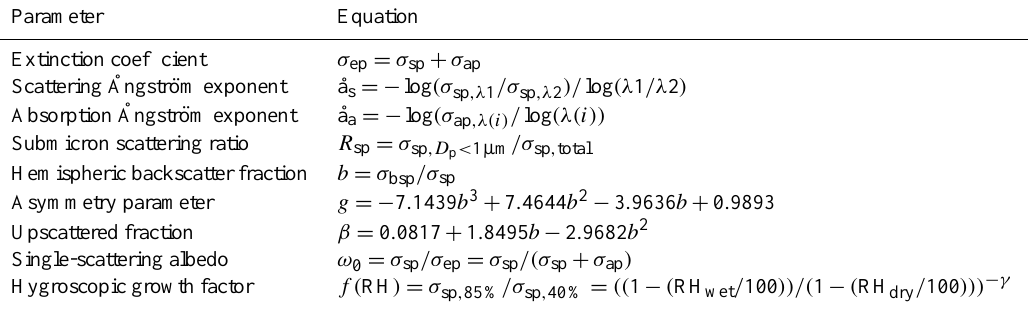
Table 2. Parameters and equations used for calculation of aerosol optical properties.